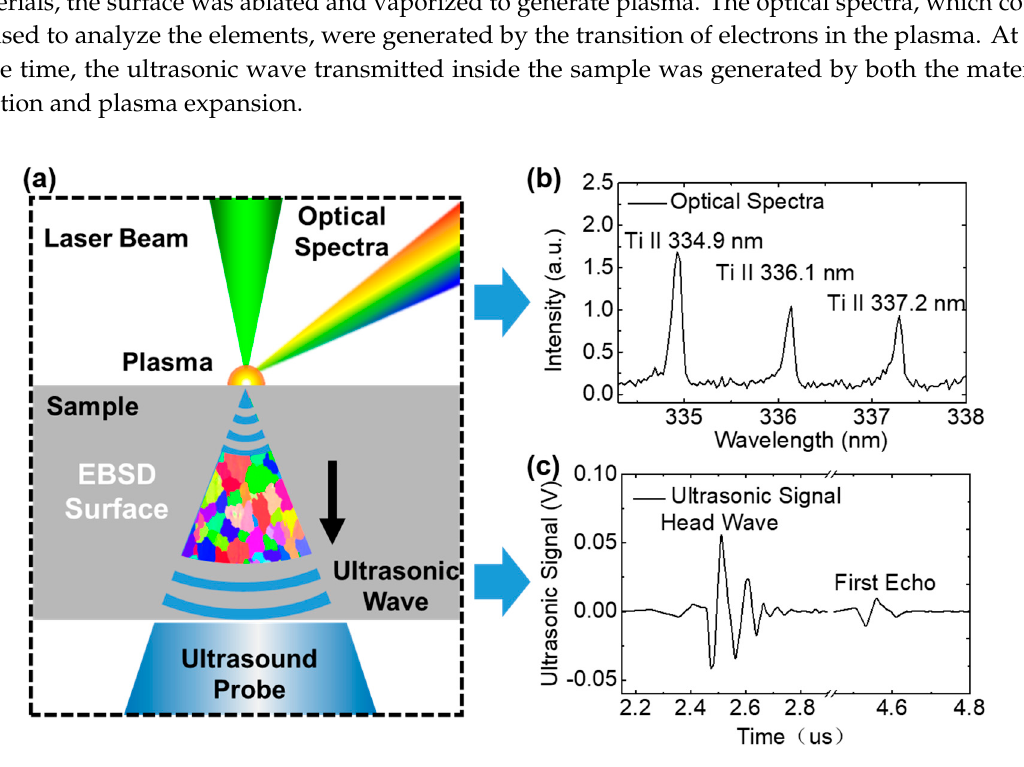
Figure 3. Schematic of optical spectra and ultrasonic signals simultaneously detected using laser opto-ultrasonic dual (LOUD) detection. ( a ) The optical spectrum and ultrasonic wave generated by laser ablation. The electron backscatter diffraction (EBSD) surface was parallel to the ultrasonic wave propagation direction. ( b ) Optical spectra peaks of Ti collected from the samples. ( c ) The ultrasonic signals show the amplitude attenuation from head wave to first echo.